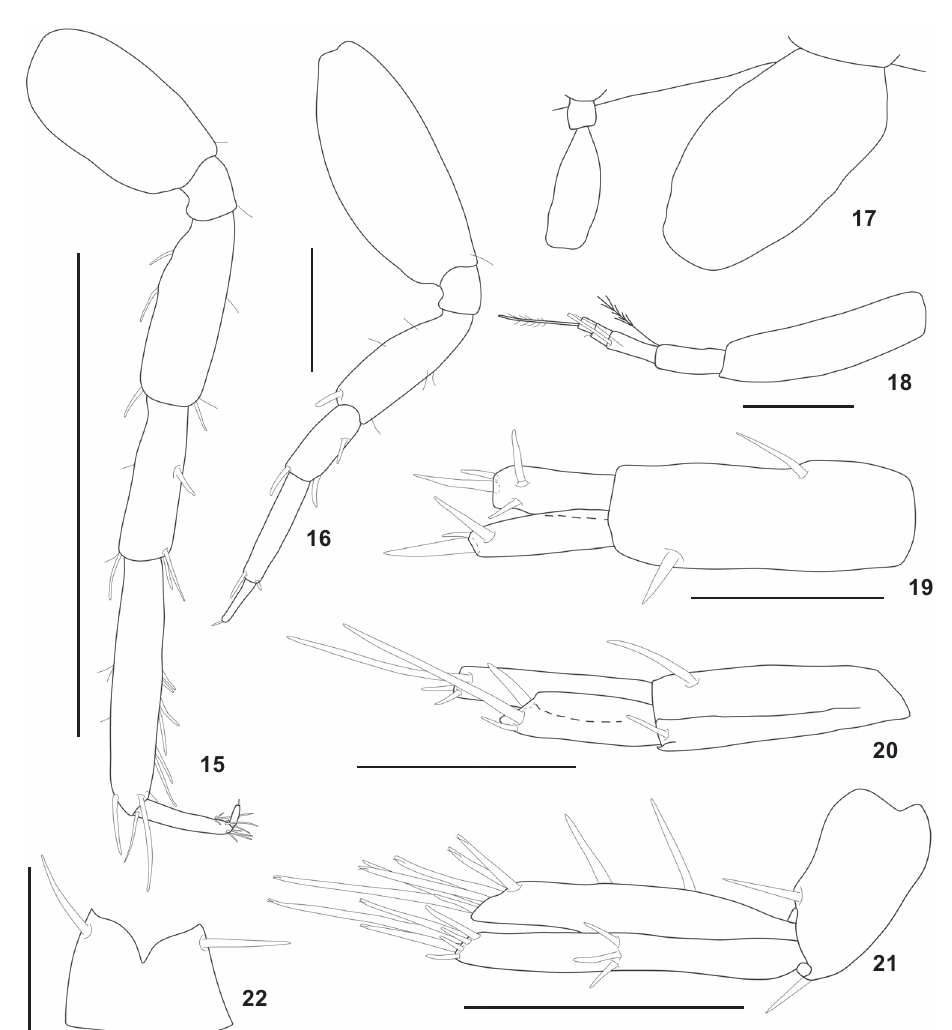
Figures 15-22. Bogidiella totakura sp. nov. , holotype, female: (15) pereopod 7; (16) pereopod 6; (17) oostegite, on pereonite 3, and coxal gill, on pereonite 4; (18) pleopod 1; (19) uropod 1; (20) uropod 2; (21) uropod 3; (22) telson. Scale bars: 15 = 0.5 mm; 22 = 0.2 mm; 16- 20 and 22 = 0.1